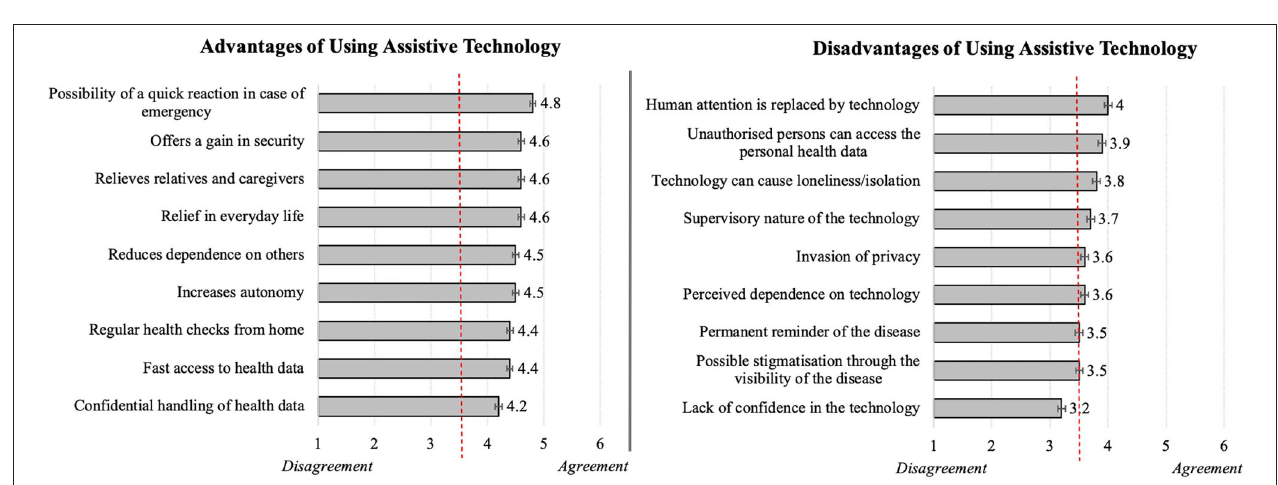
FIGURE 6 | Evaluations of advantages (Left) and disadvantages (Right) of using assistive technology ( N =